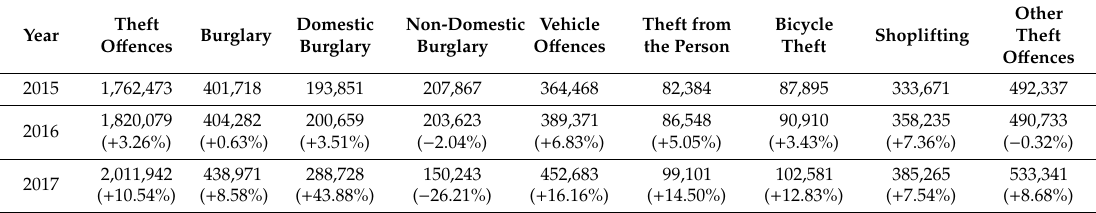
Bicycle Shoplifting Theft